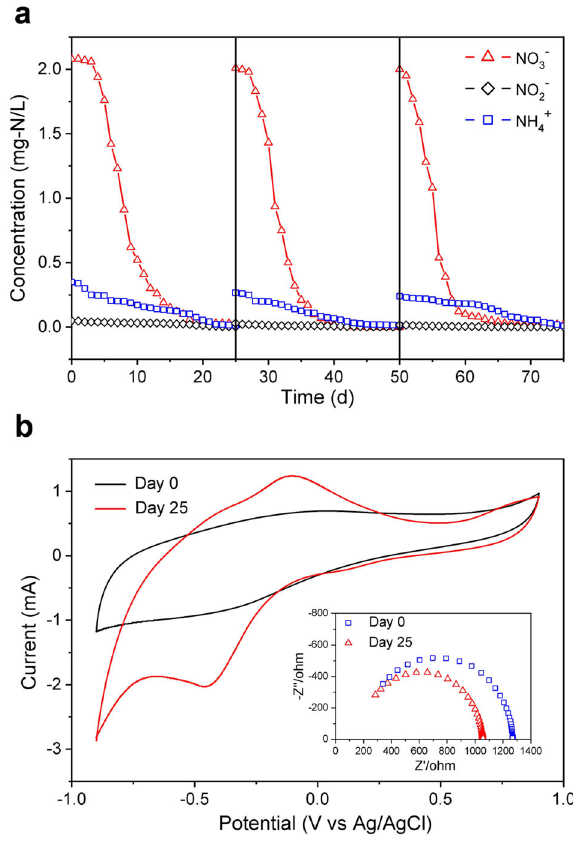
Fig. 2 NO 3 − removal and electron transfer ef fi ciency in Fe- sediment system. a NO 3 − removal ef fi ciency of Fe-sediment system over 3 cycles of 25 days each. The overlying water initially contained 2.1 mg-N/L NO 3 − (pH 7.6, 25°C). b Cyclic voltammetry curves at a scan rate of 0.1 mV/s, and Nyquist plots (inset) in the frequency range of 100 kHz to 0.1 Hz in 2.1 mg/L NO 3 − -N solution before the rod was introduced and after one cycle with the iron